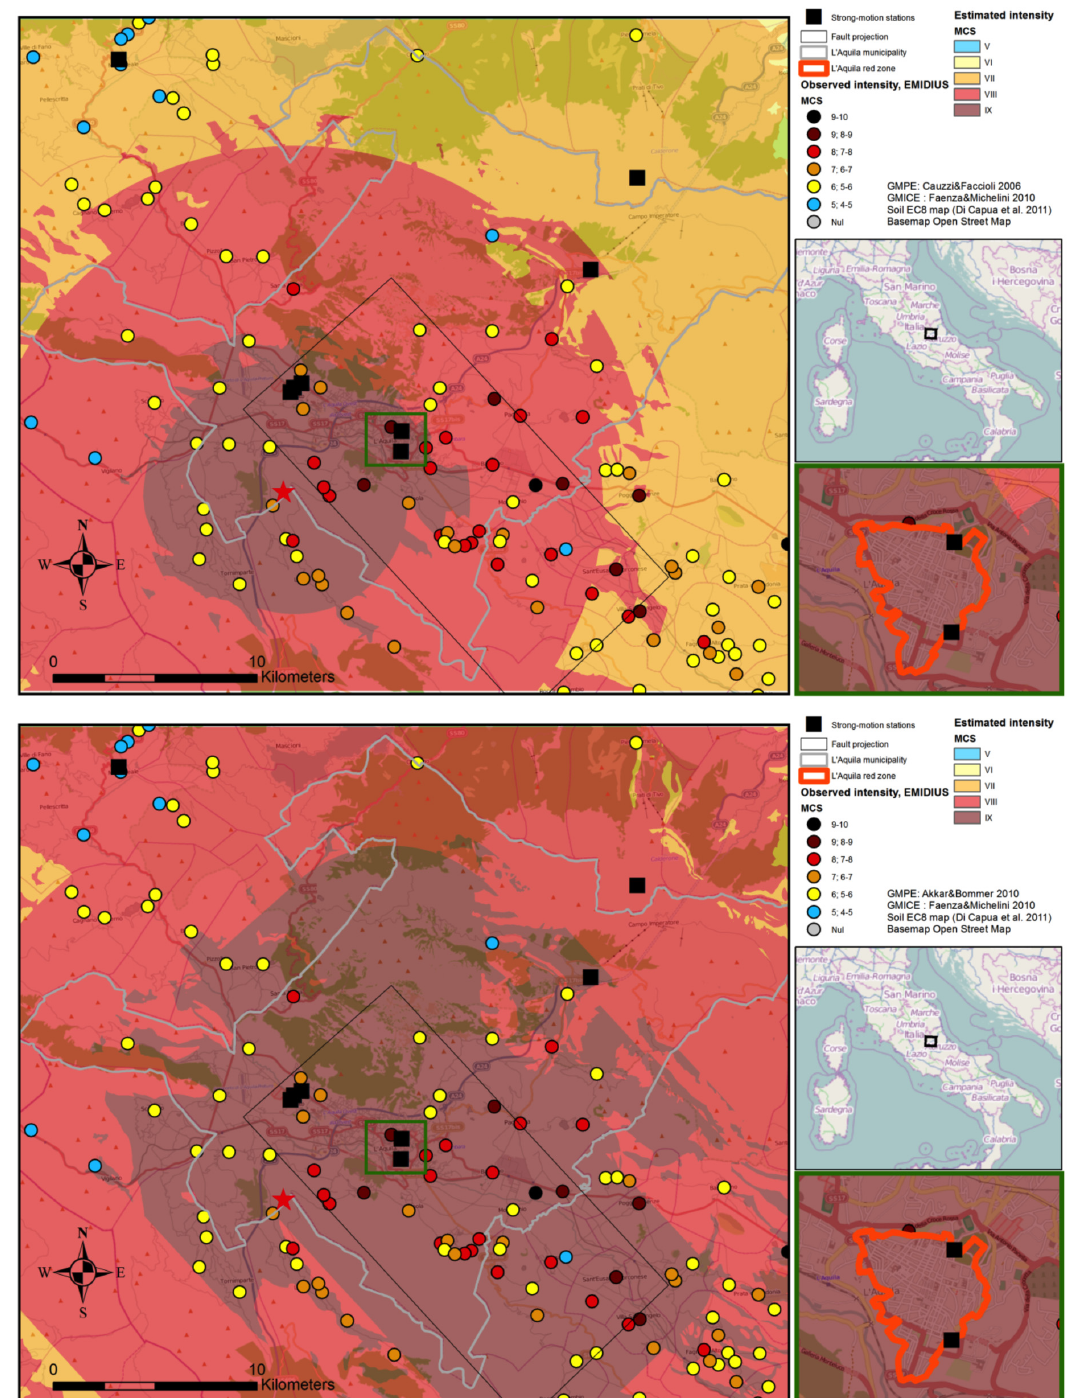
Figure 2. Comparison between hindcast macroseismic intensities (MCS) using Cauzzi and Faccioli [2008] (top) and Akkar and Bommer [2010] (bottom) and those observed (MCS,